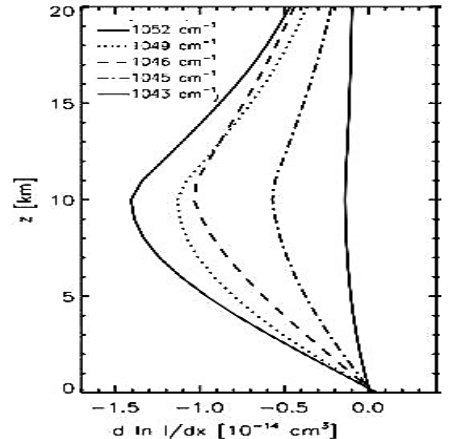
Figure 3- The sensitivity of thermal infrared radiation to the vertical distribution of ozone using American standard atmospheric